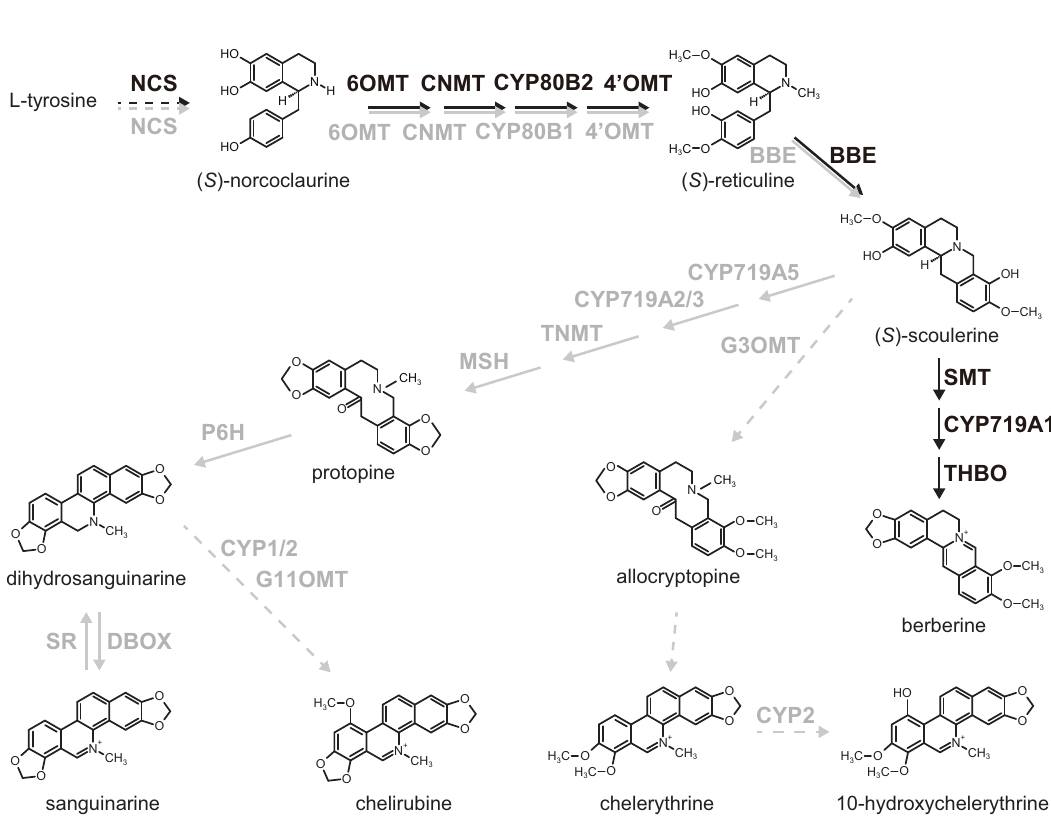
Fig 1. BIA biosynthetic pathways in BIA-producing plants. Black and gray letters show biosyntheticenzymes in C . japonica and E . californica , respectively.Broken lines indicateuncharacterized enzyme reactions. NCS, ( S )-norcoclaurine synthase; 6OMT, ( S )-norcoclaurine6- O -methyltransferase; CNMT, ( S )-coclaurine- N -methyltransferase; CYP80B1, ( S )- N - methylcoclaurine 3’-hydroxylase; 4’OMT, ( S )-3’-hydroxy- N -methylcoclaurine 4’- O -methyltransferase; BBE, berberine bridgeenzyme; SMT, ( S )-scoulerine 9- O -methyltransferase of C . japonica ;CYP719A1,( S )-canadine synthase; THBO, ( S )-tetrahydroprotoberberine oxidase;CYP719A5, ( S )-cheilanthifolinesynthase; CYP719A2/3,( S )-stylopinesynthase; TNMT, ( S )-tetrahydroprotoberberinecis- N -methyltransferase, MSH, ( S )- N -methylstylopine14-hydroxylase; P6H, protopine6-hydroxylase; DBOX, dihydrobenzophenanthridine oxidase;SR, sanguinarine reductase; G3OMT, ( S )- scoulerine9- O -methyltransferase of Californiapoppy; G11OMT, putative 10-hydroxydihydrosanguinarine10- O - methyltransferase. CYP1 and CYP2 are putative dihydrobenzophenanthridine 10-hydroxylases.